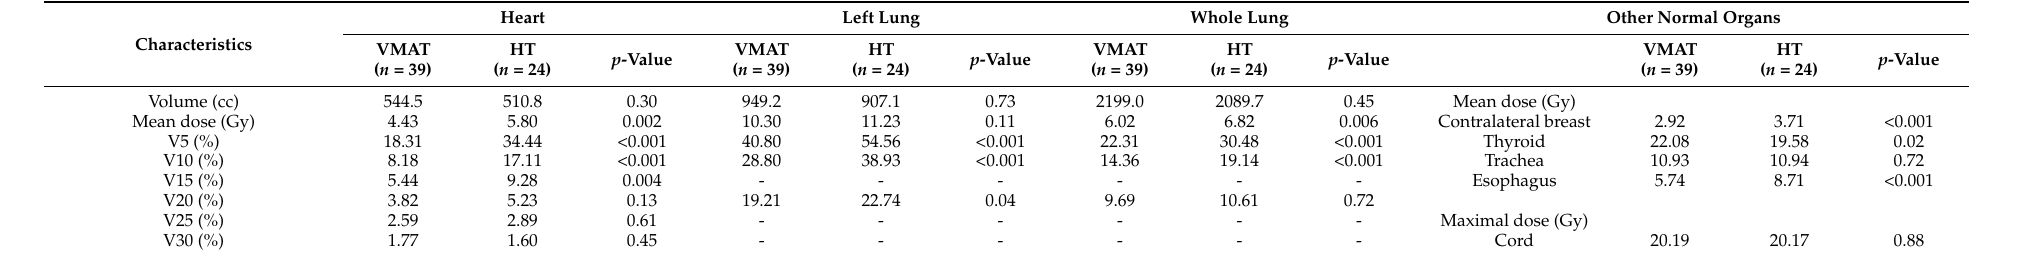
Table 3. Comparison of RT treatment factors and dosimetry parameters between VMAT and HT in patient subgroup of RNI with IMN.